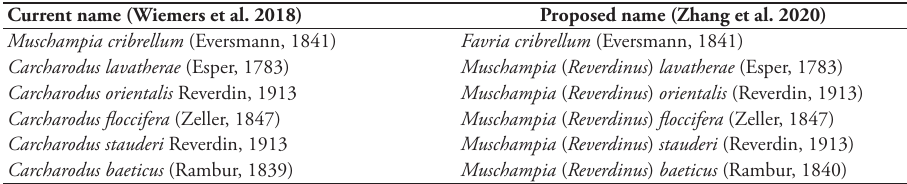
Figure 1. Time-calibrated tree of European butterflies (Lepidoptera: Papilionoidea) with time scale and taxonomic assignment to subfamilies and families. table 2. Proposal for changes in the current taxonomic checklist by Wiemers et al. (2018) according to the recent revision of Carcharodina by Zhang et al.